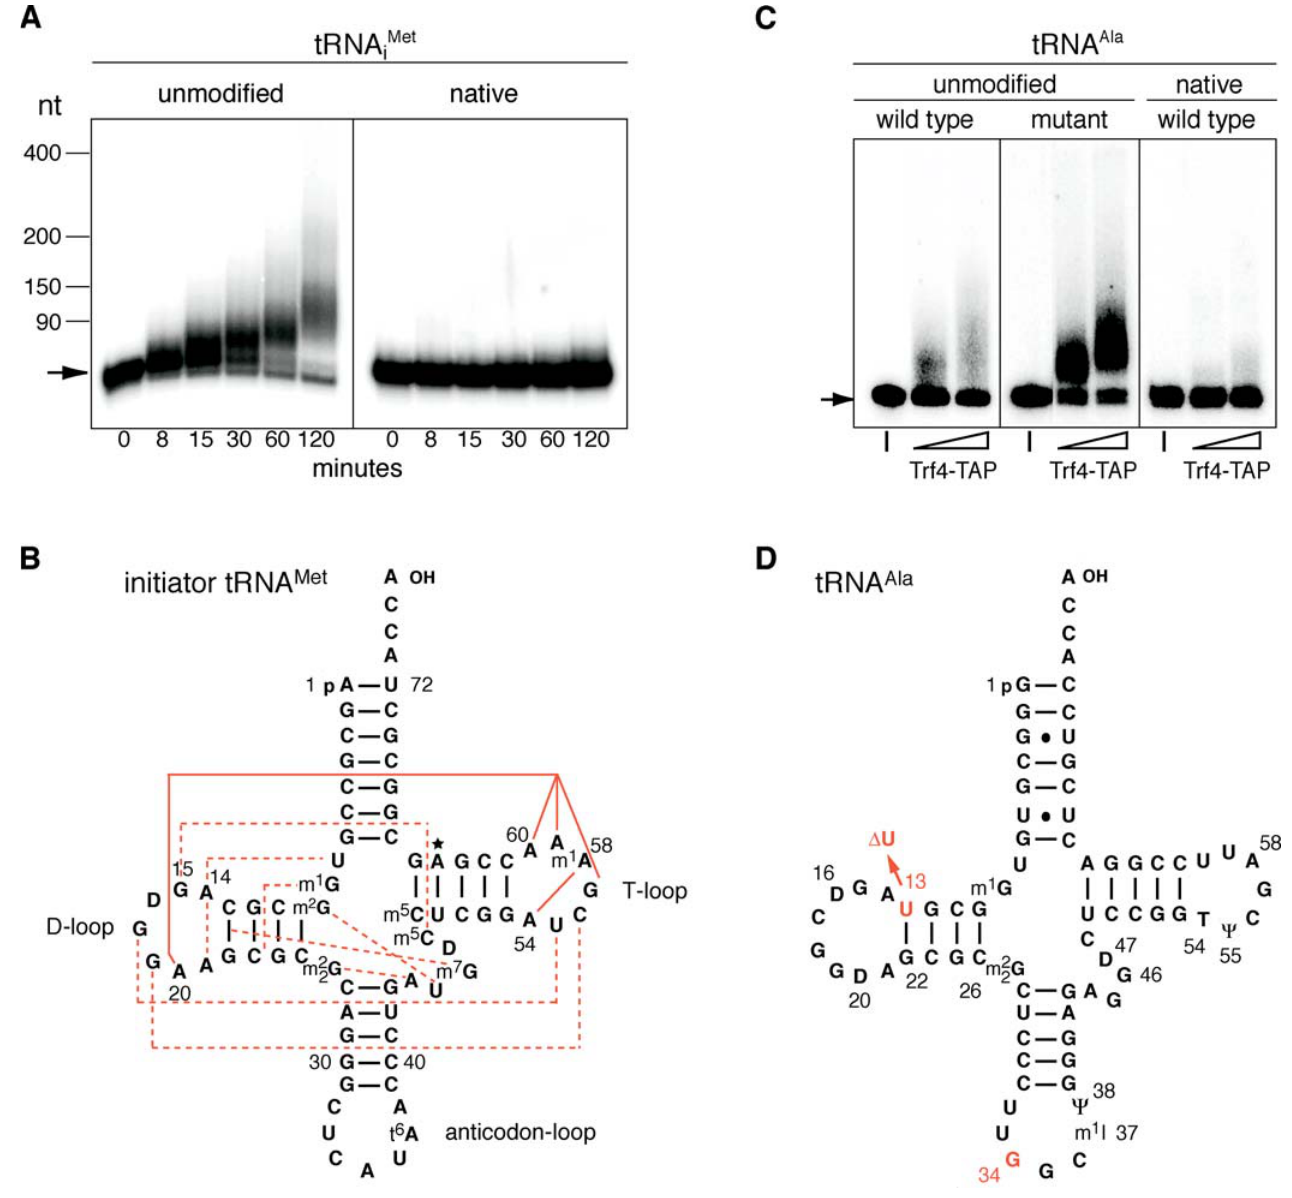
(A) Polyadenylation assay with Trf4p-TAP and unmodified and native tRNA iMet as substrates. The 5 9 -end-labeled tRNAs were incubated with 50 ng of Trf4 complex for times indicated and resolved by gel electrophoresis. The migration position of the input tRNA is indicated by an arrow. (B) Sequence of yeast tRNA iMet in cloverleaf form with all the known nucleotide modifications. Tertiary interactions are indicated in solid and dashed red lines. The network of hydrogen bonds involving A20, G57, m 1 A58, A59, and A60, necessary and unique for tertiary interactions in eukaryotic initiator tRNA, is outlined by solid red lines. A*, 5 9 -phosphoribosyl-2 9 -adenosine; D, dihydrouridine; m 1 A, 1-methyladenosine; m 1 G, 1-methylguanosine; m 2 G, N 2 -methylguanosine; m 2 2 G, N 2 ,N 2 -dimethylguanosine; m 7 G, 7-methylguanosine; t 6 A, N 6 -threonylcarbamoyladenosine. (C) Polyadenylation activity of Trf4p-TAP on unmodified wild-type, A34G D U13 mutant tRNA Ala , and native tRNA Ala . The 5 9 -end-labeled tRNAs were incubated with 20 or 50 ng of Trf4 complex for 30 min at 30 8 C. Lane I in each panel shows input tRNA. tRNAs were separated on 10% denaturing gels. (D) Yeast tRNA Ala in its cloverleaf form. All known nucleotide modifications are indicated. In the mutant tRNA Ala used in this study, the uracil at position 13 was deleted, and the A34 in the anticodon loop was changed to guanine (marked in red). w , pseudouridine; m 1 I 37 , 1-methylinosine generated by deamination of adenosine at position 37. Other modifications are labeled as in (B). DOI: 10.1371/journal.pbio.0030189.g004